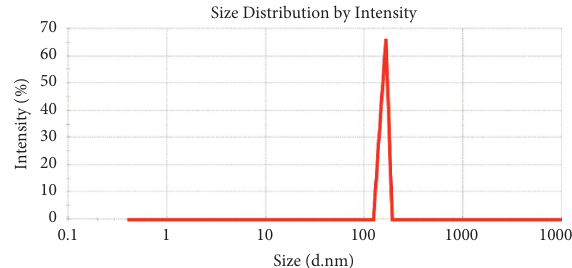
Figure 8: Particle size distribution graph of GSF.